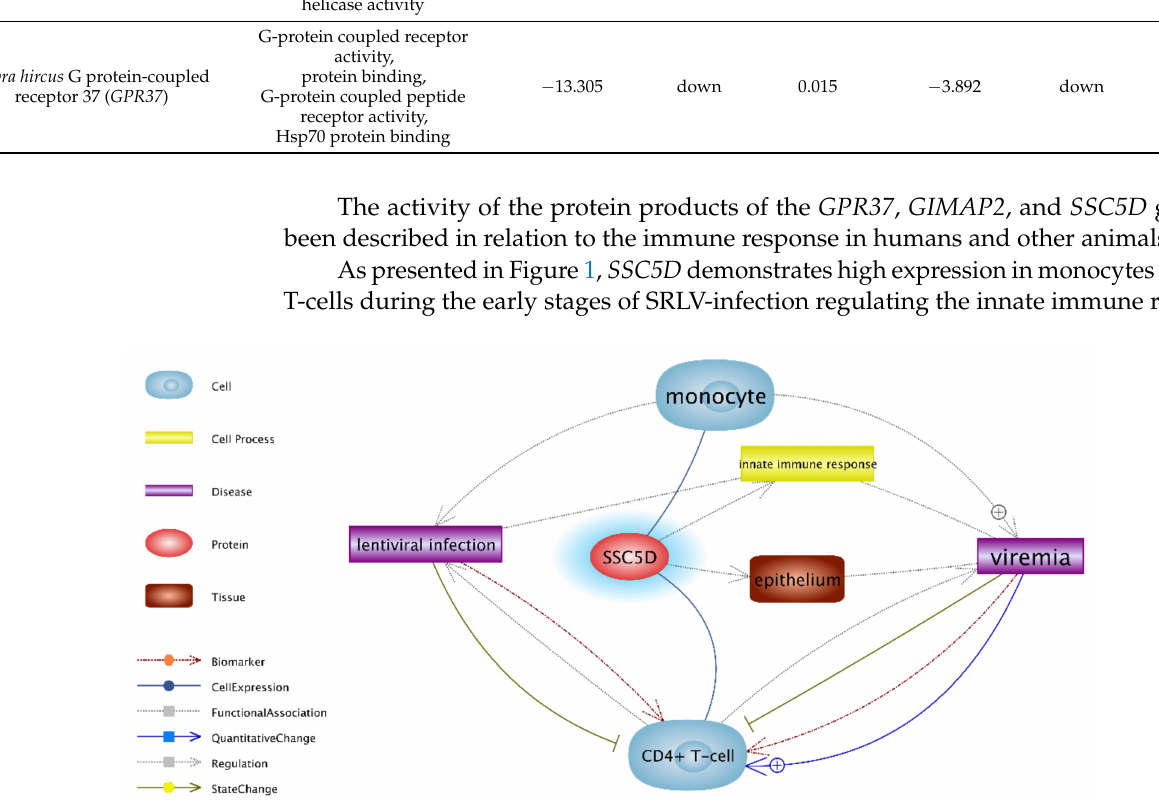
Figure 1. Direct links between the SSC5D protein and monocytes and CD4 + T cells during lentivirus infection. Upregulated expression of the SSC5D gene in PBNCs of SRLV-SP vs. SRLV-SN goats, as analyzed by the Pathway Studio program [30]. The blue line highlights the upregulation of the gene in SRLV-SP goats vs. SRLV-SN goats. SSC5D—scavenger receptor cysteine-rich family member with five domains (alias S5D-SRCRB); PBNCs—peripheral blood nuclear cells; RT-qPCR— quantitative reverse transcription PCR; SRLV-SP—small ruminant lentivirus-seropositive; SRLV-SN—small ruminant